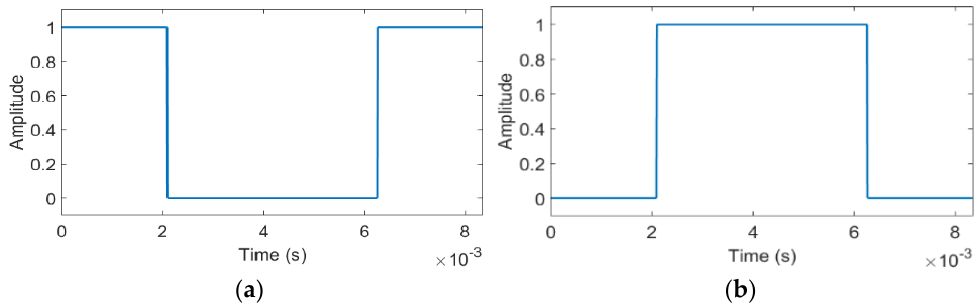
Figure 1. ( a ) The waveform for the s 0 symbol. ( b ) The waveform for the s 1 symbol. A binary sequence can be transmitted by concatenating the waveforms of the corre- sponding symbols (e.g., s 0 for a bit equal to 0 and s 1 for a bit equal to 1). If the waveforms are sampled every T s seconds, according to Equation (1), the resulting sequence has only two possible values: it is either equal to the transmitted sequence or equal to its negated value, no matter where the starting sampling point falls on the first symbol (i.e., no matter the moment when the receiver was started, as long as all the symbols are sampled). This property is illustrated in Figure 2, where all three possible cases of sampling are analyzed for the transmitted binary sequence equal to 00011011. If the sampling point is before the first quarter of the symbol’s waveform, the extracted sequence is 11100100 (the sampling points marked with triangles). If the sampling point is between the first quarter and the last quarter of the symbol’s waveform, the extracted sequence is 00011011 (the sampling points marked with crosses). If the sampling point is between the first quarter and the last quarter of the symbol’s waveform, the extracted sequence is 11100100 (the sampling points marked with circles).